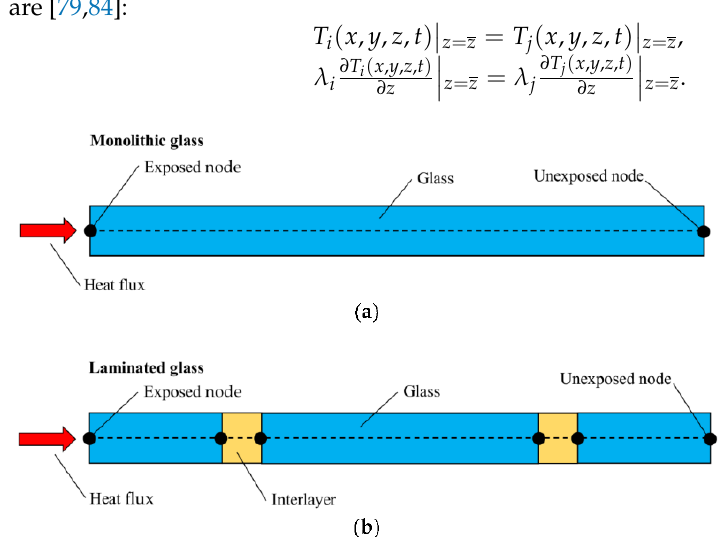
Figure 3. Schematic representation of a reference 1D heat transfer model for ( a ) monolithic and ( b ) laminated glass elements (cross-section layout). Figure reproduced from [70] under the terms and conditions of the CC-BY copyright license agreement.